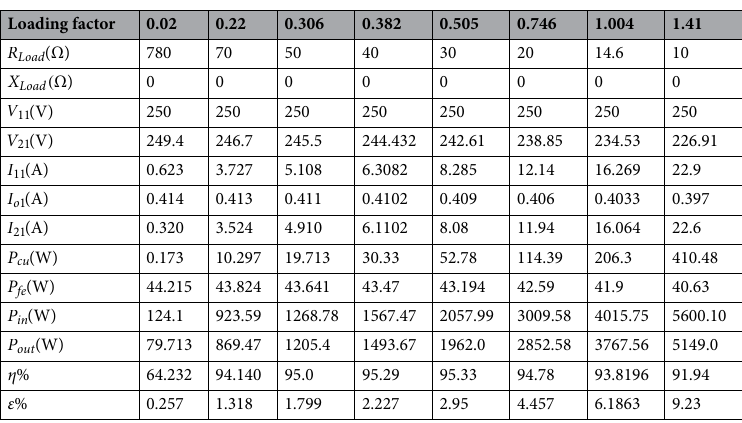
Table 5. Case 2 transformer performance for different loading% at